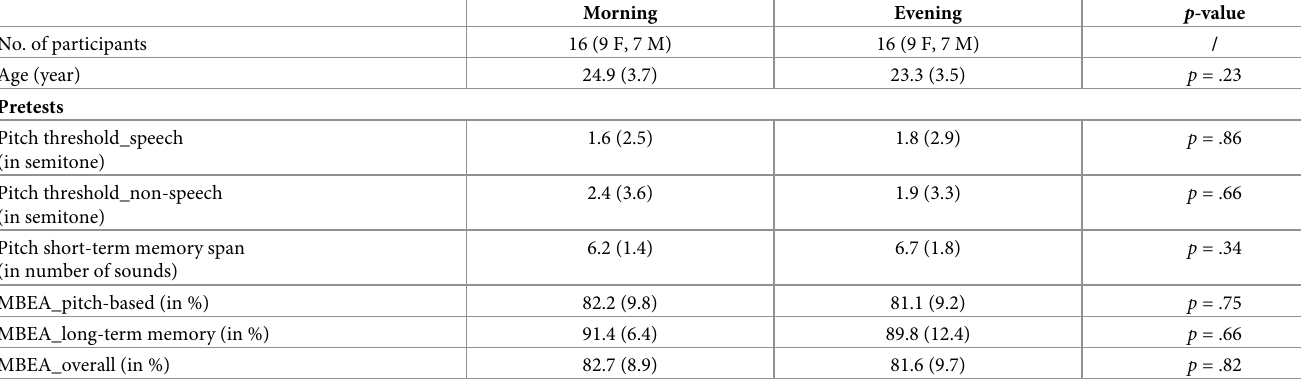
Table 1. Demographic characteristics of the morning and evening training